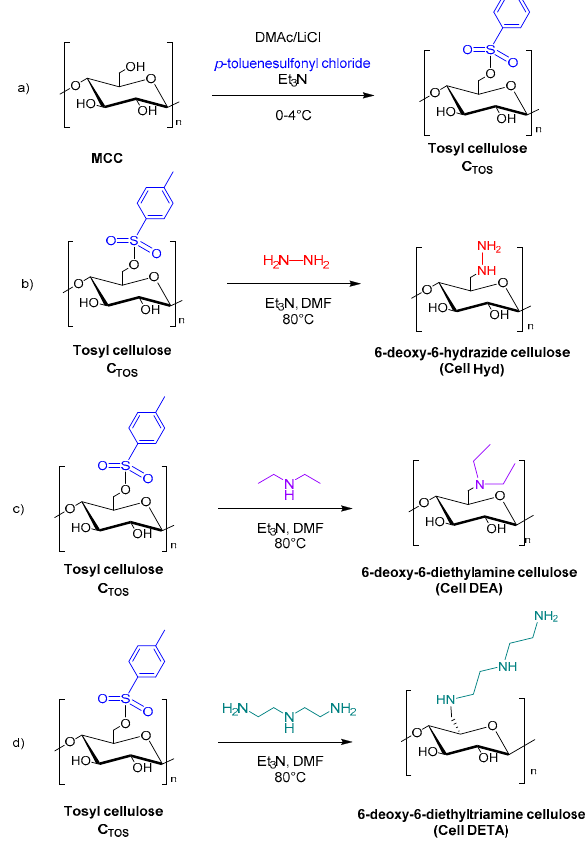
Figure 16. Synthesis of microcrystalline cellulose (MCC) derivatives: ( a ) tosyl cellulose (C TOS ); ( b ) 6-deoxy-6-hydrazide cellulose (Cell Hyd); ( c ) 6-deoxy-6-diethylamine cellulose (Cell DEA); ( d ) 6-deoxy-6-diethyltriamine cellulose (Cell DETA).